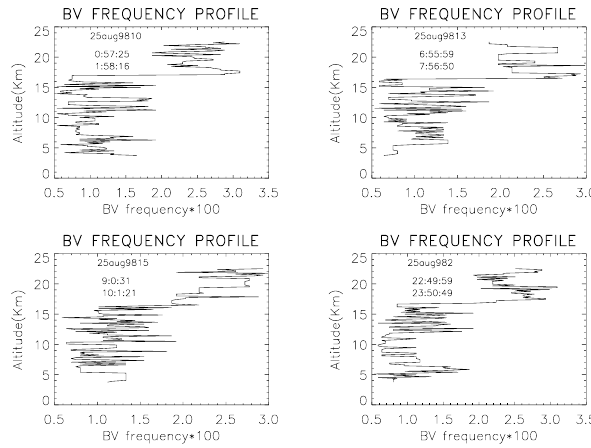
Fig. 2. Altitude variation of ω N in the troposphere-stratosphere region on 25 August 1998 during the time intervals (a) 00:57 to 01:58 (b) 06:55 to 07:56 (c) 09:00 to 10:01 and (d) 22:49 to 23:50 on 24 August